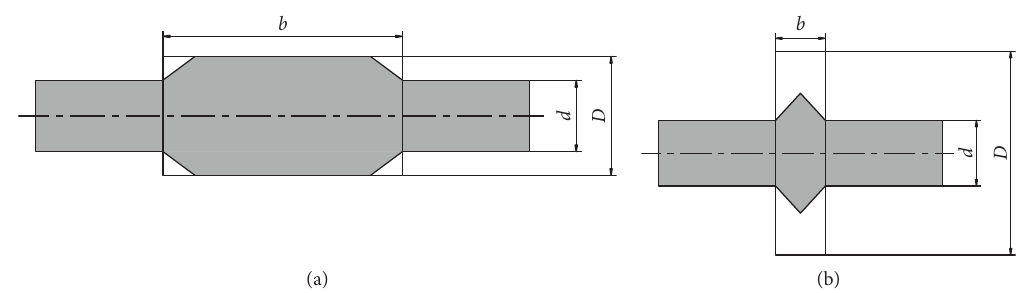
Figure 7: The modes of the stepped shaft. (a) High b / D and high d / D and (b) low b / D and low d / D .